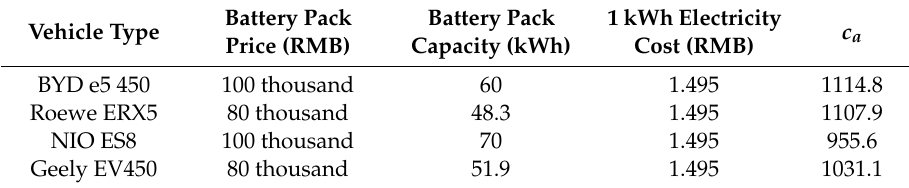
Table 2. Conversion coe ffi cient of battery life loss c a for four pure electric vehicles. Vehicle